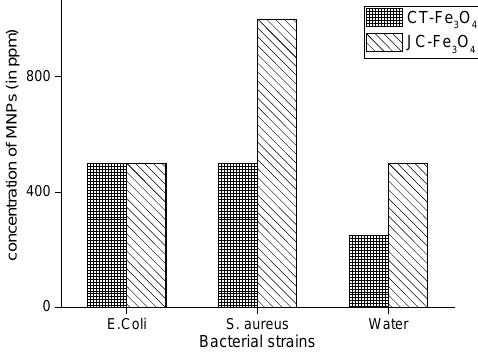
Figure 11. Minimum Inhibitory Concentration (MIC) for different bacteria.